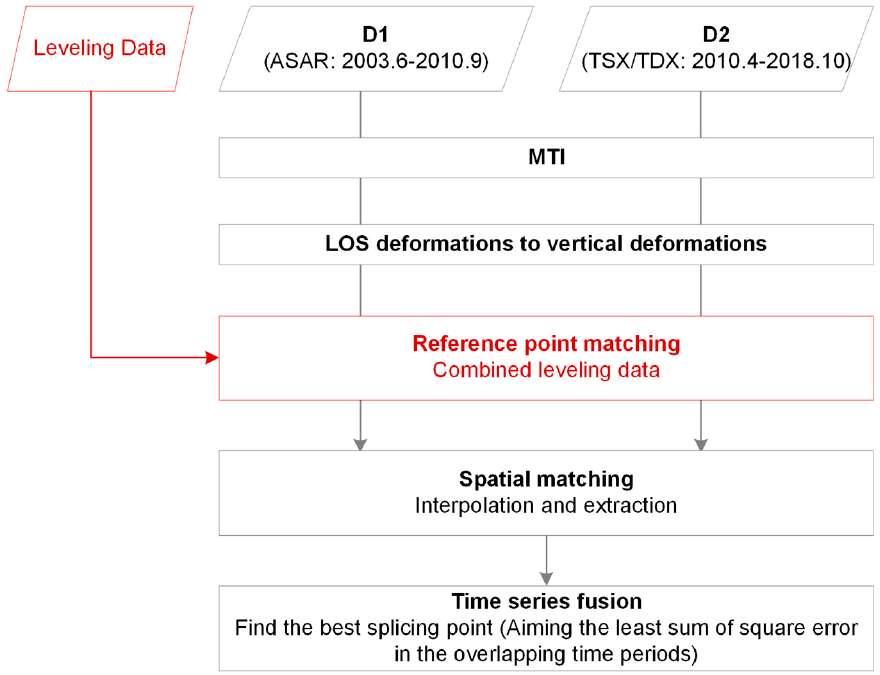
Figure 2. Workflow of the multi-sensor Multi-temporal InSAR time-series fusion (MMTI-TSF) algorithm and its improved process (red text shows the improvement to the MMTI-TSF).